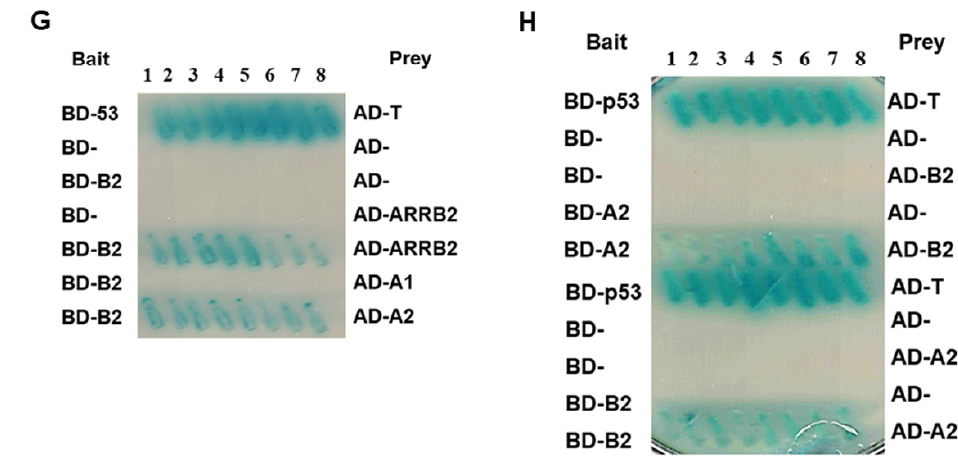
Figure 5. BCAS1-SV1 interacts with the c-terminus of β -arrestin through an intermediate region. ( A ) Schematic drawing of the deletion mutants of BCAS1-SV1 used in the yeast two-hybrid assay. ( B – D ) The B2 fragment of BCAS1-SV1 (160–312 amino acid) interacted strongly with β -arrestin 2. Diploid cells (blue) contain four reporter genes that are activated in response to two-hybrid interactions. Diploid cells containing BD-p53 and AD-T were used as a positive control. ( E ) Schematic drawing of the deletion mutants of β -arrestin used in the yeast two-hybrid assay. ( F – H ) The A2 frag- ment of β -arrestin (186–410 amino acid) had a strong interaction with the B2 fragment of BCAS1-SV1. Diploid cells containing BD-p53 and AD-T were used as a positive